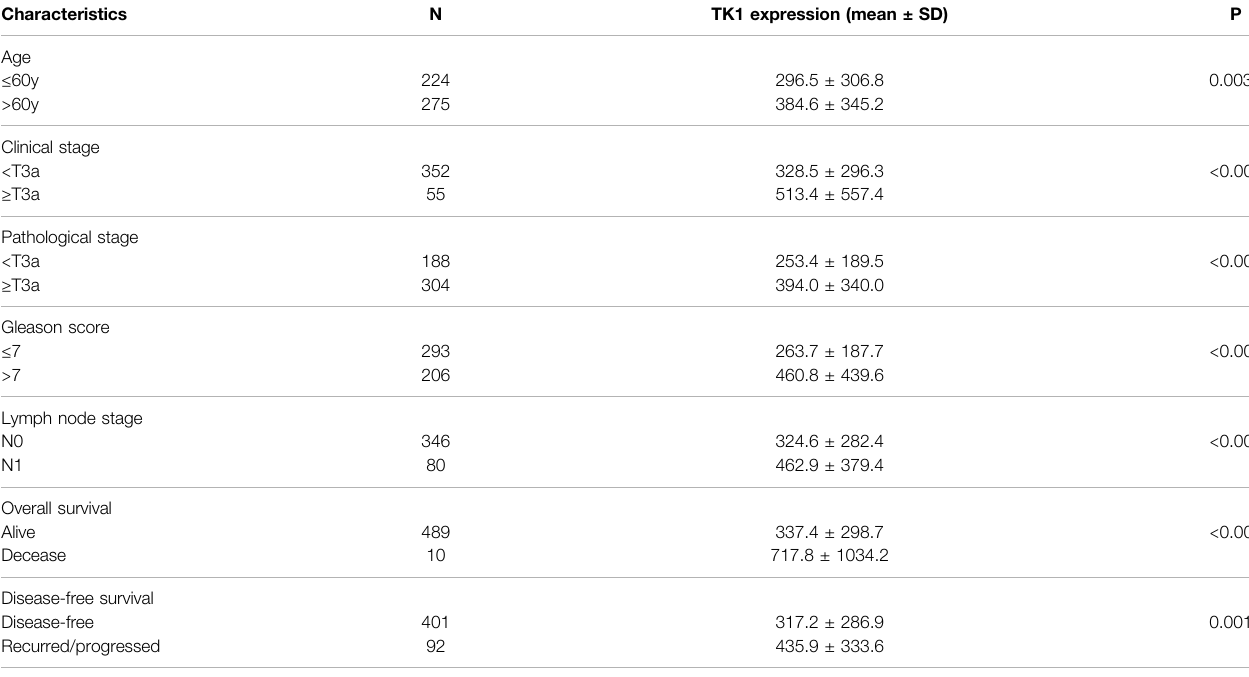
TABLE 3 | The correlation between clinicopathological characteristics and TK1 expression in the PRAD dataset.